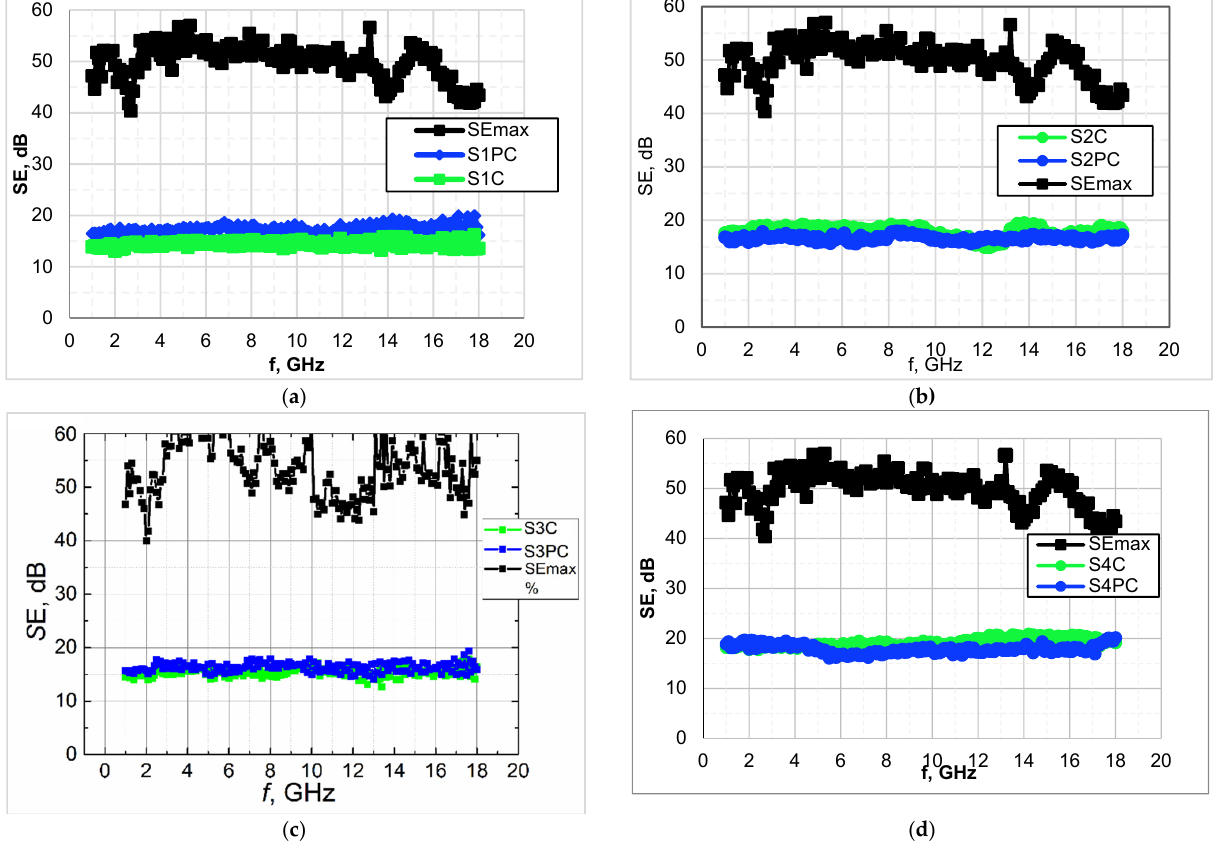
Figure 7. Shielding effectiveness SE, dB of tested fabrics coated with PEDOT:PSS formulation: ( a )—I group of samples; ( b )—II group of samples; ( c )—III group of samples; ( d )—IV group of samples.